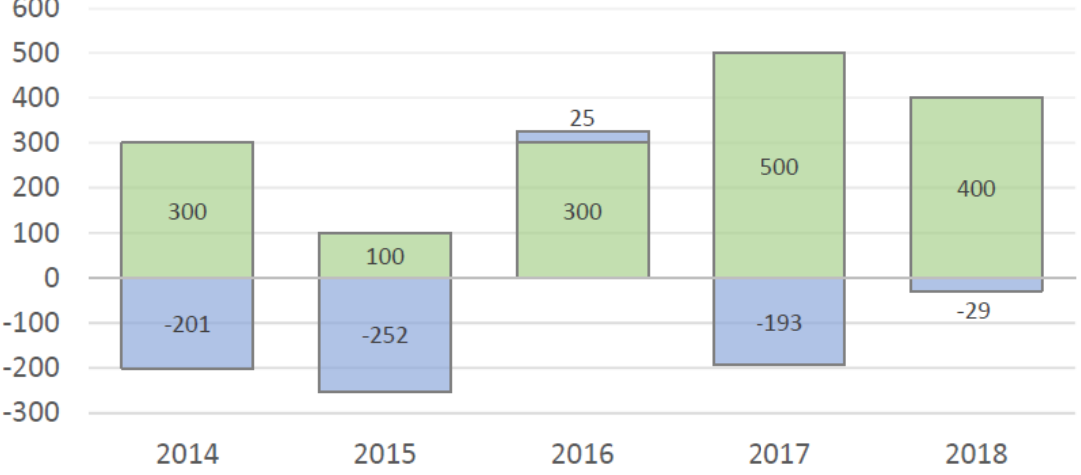
Figure 9: Outflow of profit share and withdrawal from retained earnings account STRABAG (CZK million), (source: Annual report of STRABAG 2014-2018, data processed by the